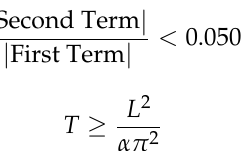
Table 2. Minimum, maximum, and average fl ow across the sample at the speci fi ed time intervals compared to the theoretical Darcy fl ow (Equation (4)) from the parameters in Table 1. Note that if the sample has a minimum fl ow of zero, the average fl ow was not considered.